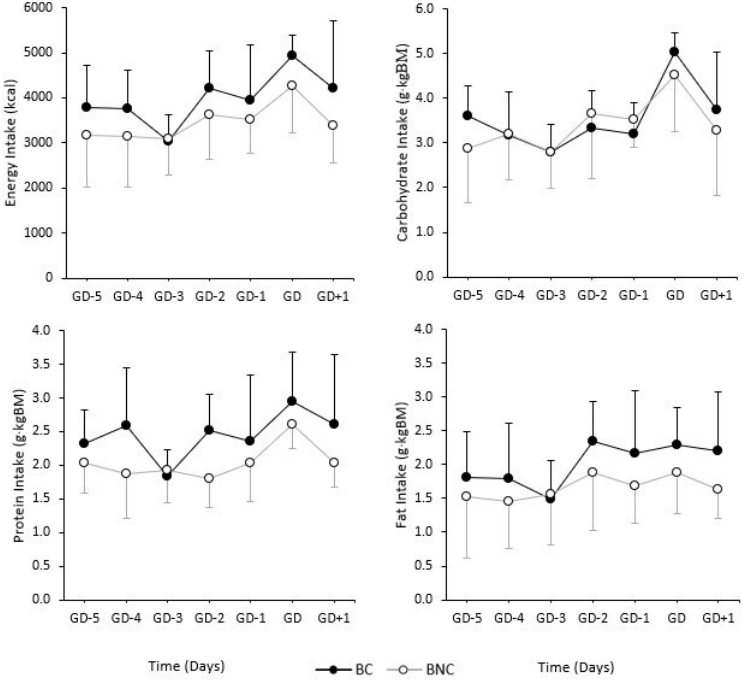
Figure 2. Daily absolute energy intake and relative macronutrient intake during competition weeks (GD-5, GD-4, GD-3, GD-2, GD-1, GD, GD+1) among backs within a catered (BC) and non-catered (BNC) environment. Error bars represent standard deviation.